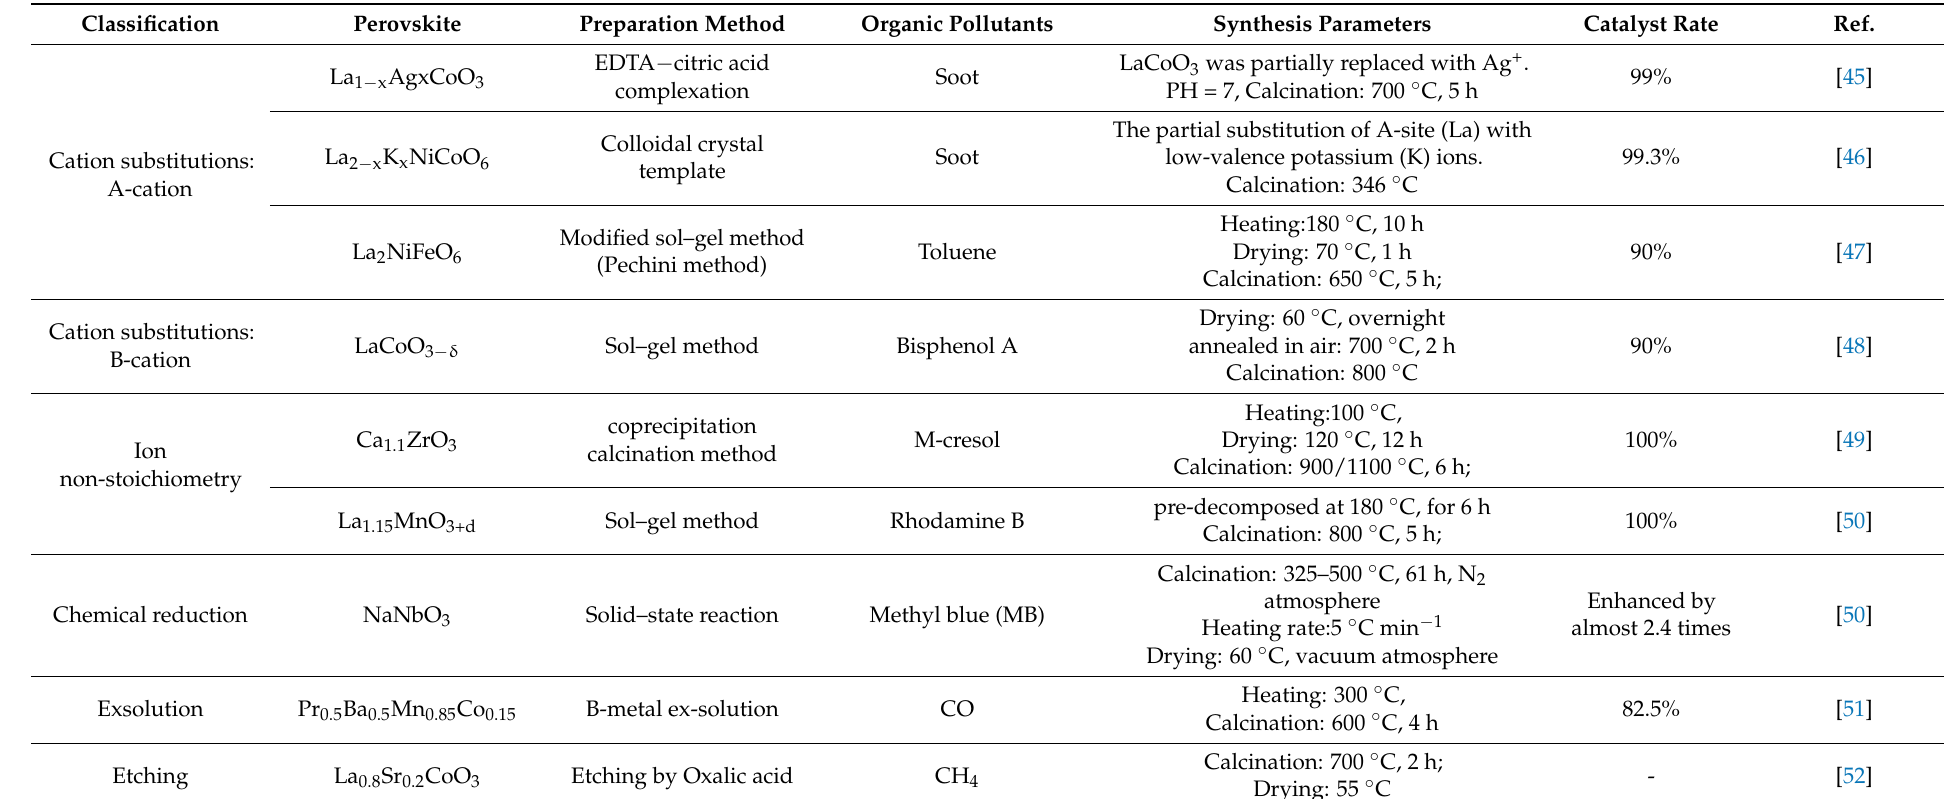
Table 2. Summary of approaches to improving oxygen vacancies in